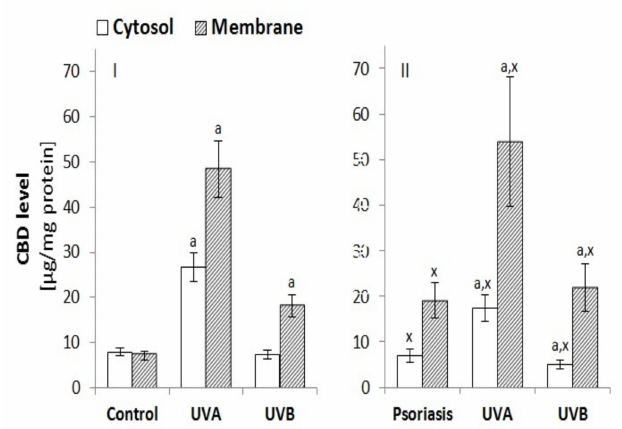
Figure 7. E ff ect of CBD (4 µ M) on this phytocannabinoid level in cytosol and the membranes of keratinocytes exposed to UVA (30 J / cm 2 ) and UVB (60 mJ / cm 2 ) radiation. The keratinocytes were obtained from healthy subject (n = 15) ( I ) and patients with psoriasis vulgaris (n = 30) ( II ) The mean values ± SD are presented with statistically significant di ff erences: a -vs. control / psoriasis group; x -psoriasis vs. control group; p <